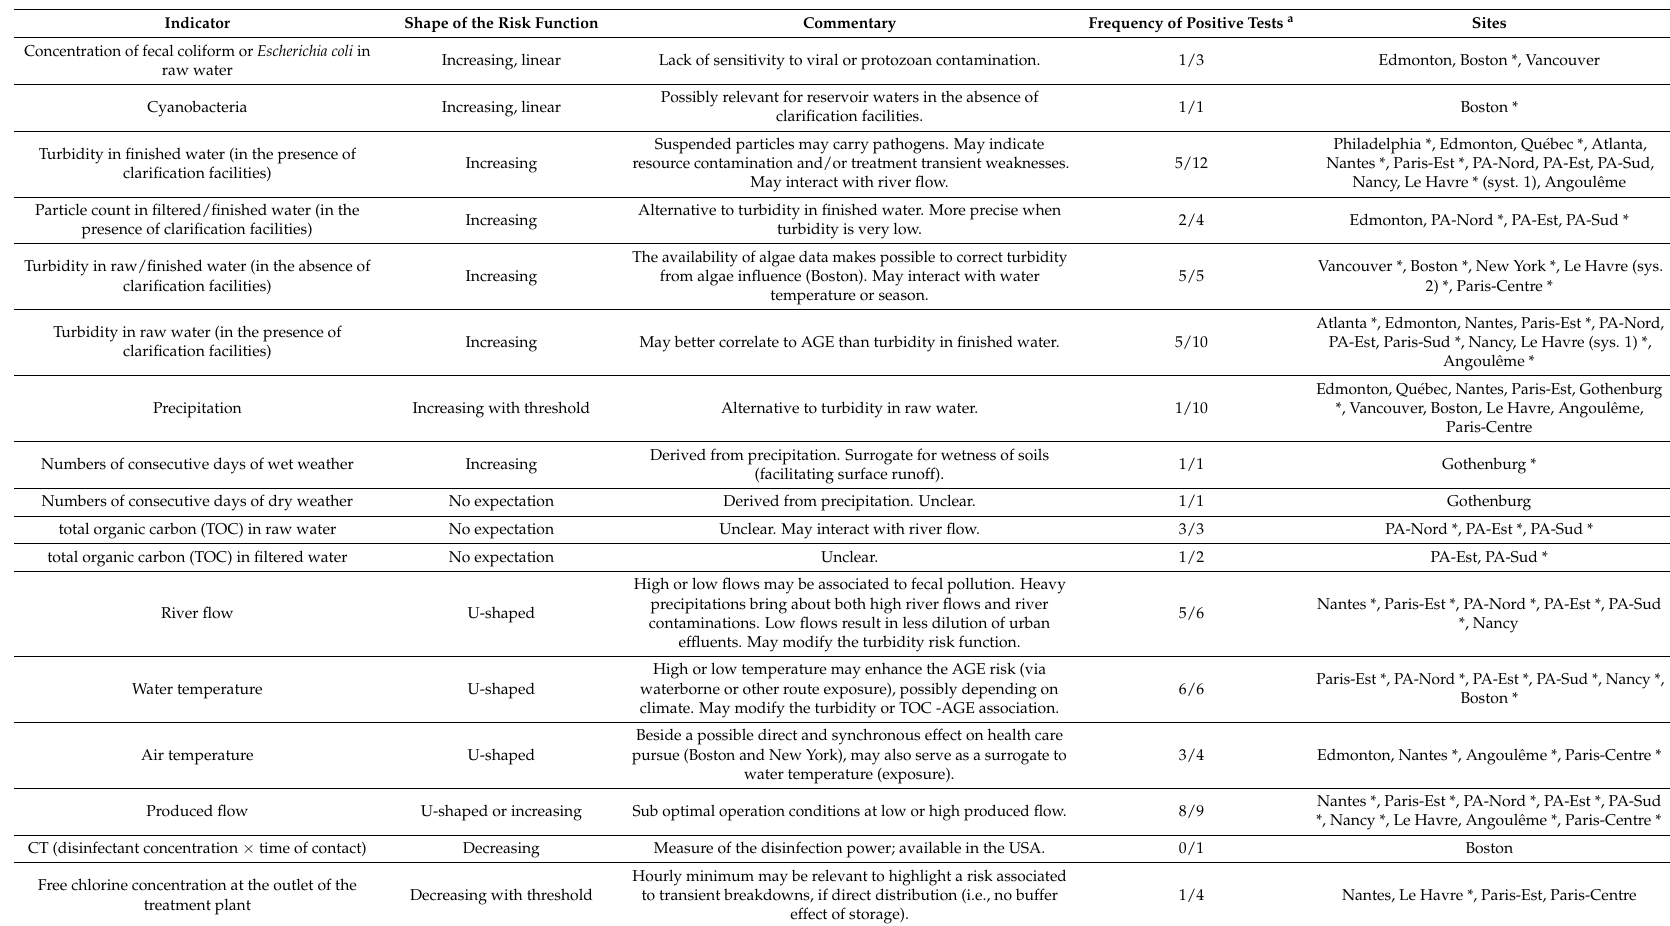
Table 2. Indicators tested as exposure proxies in the selected time series studies